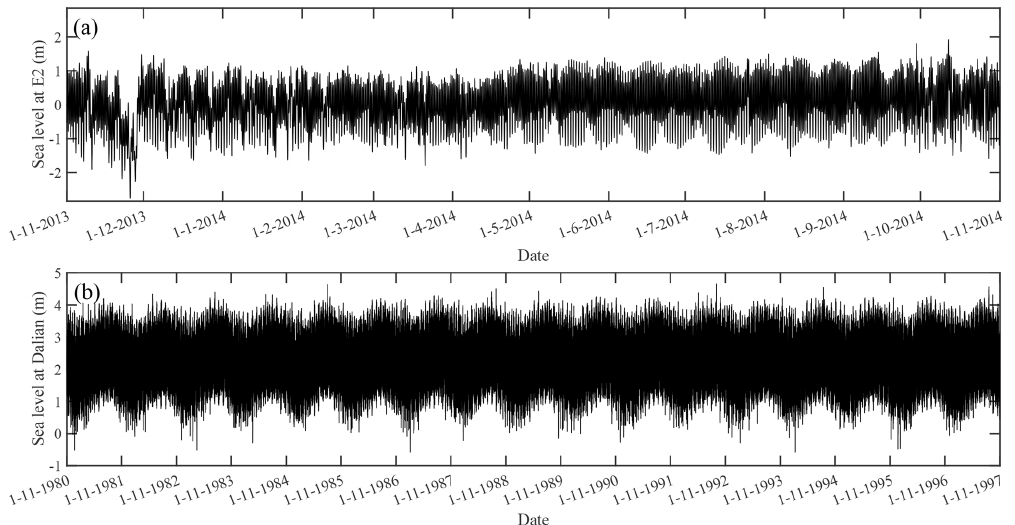
Figure 2. Time series of the observed sea level at (a) E2 and (b)